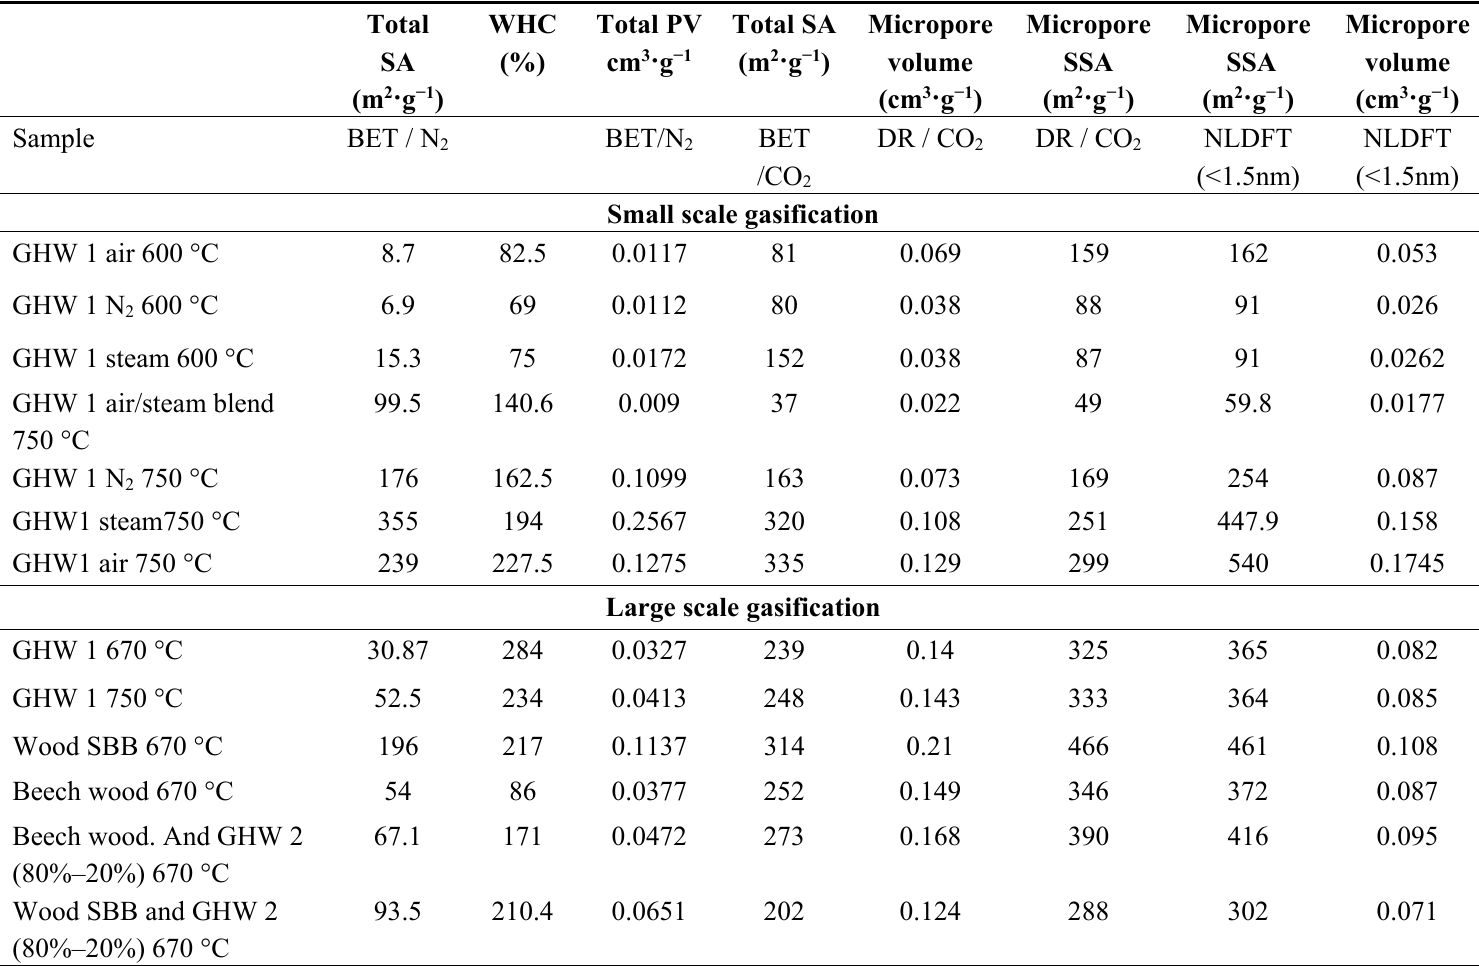
Table 6. Surface Area and porosity results on selected gasification samples. The larger scale experiments were all performed with air as fluidizing